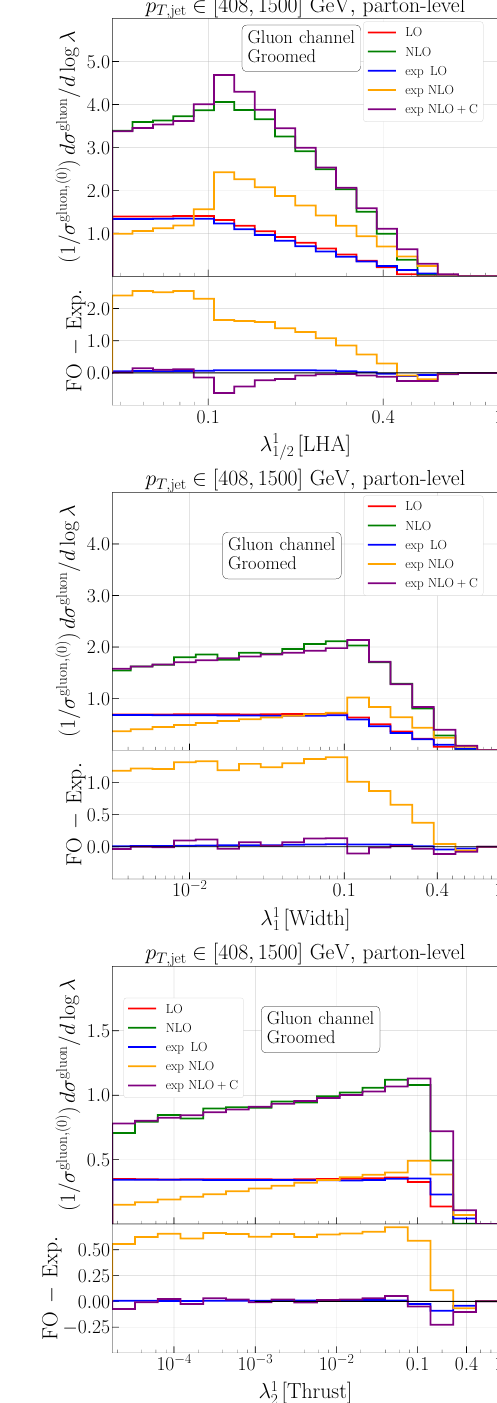
, for α ∈ { 1 / 2 , 1 , 2 } , compared α